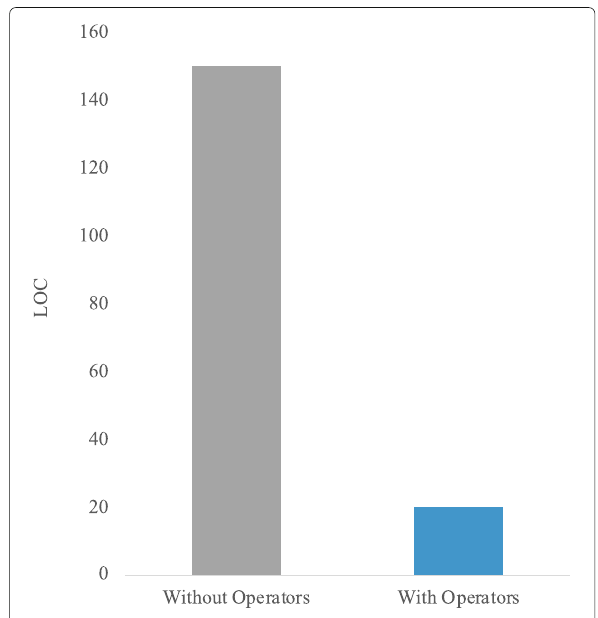
Fig. 11 Lines of Code (LOC) required to build the